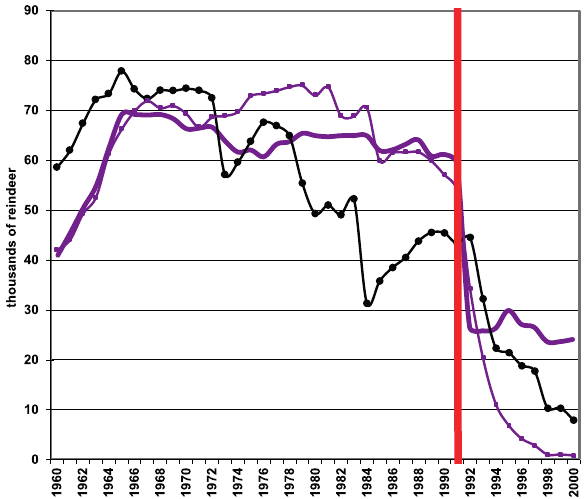
Fig. 5. The population of of domesticated reindeer (in thousands) in different regions [central ( ― ), northeastern